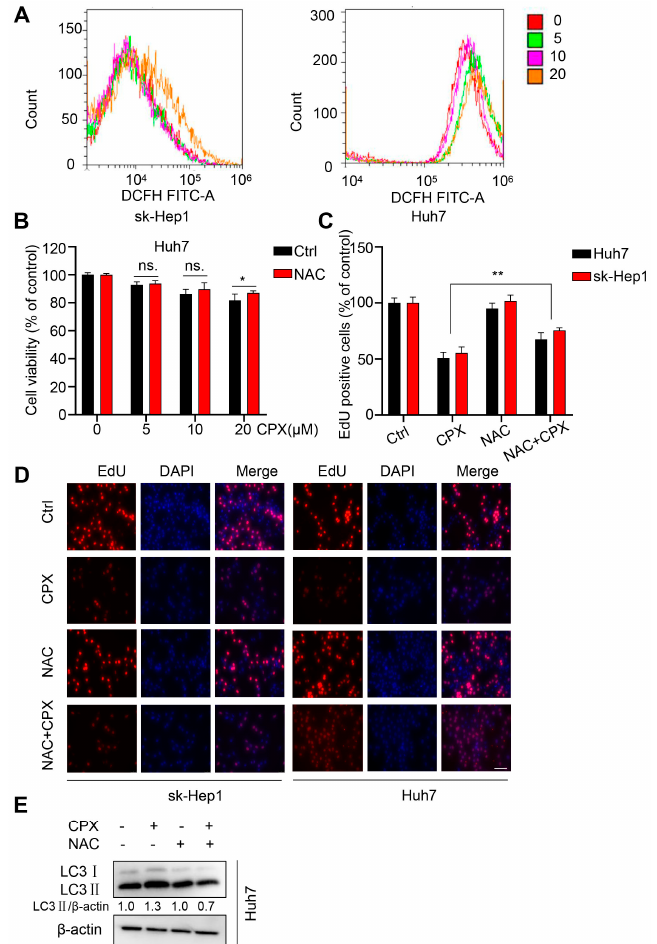
Figure 6. ROS are responsible for the anti-cancer effects of CPX. ( A ) ROS level was analyzed by DCFH-DA staining via flow cytometry in sk-Hep1 and Huh7 cells treated with indicated concentrations of CPX for 24 h. ( B ) The CCK8 assay determined cell viability of HCC cells treated with NAC (5 mM), CPX (20 µ M) or a combination thereof for 24 h. ( C , D ) EdU assay of HCC cells treated with or without 5 mM NAC in the presence or absence of 20 µ M CPX for 24 h. The EdU positive cell rate was quantitated. Scale bar, 100 µ m. ( E ) Immunoblotting analysis of LC3 expression was detected in Huh7 cells treated with NAC (5 mM), CPX (20 µ M) or a combination thereof for 24 h. Relative intensity of LC3-II was quantified by normalization to β -actin by ImageJ software. Data are means ± s.d. and are representative of 3 independent experiments. *, p < 0.05, **, p < 0.01. Statistical significance compared with respective control